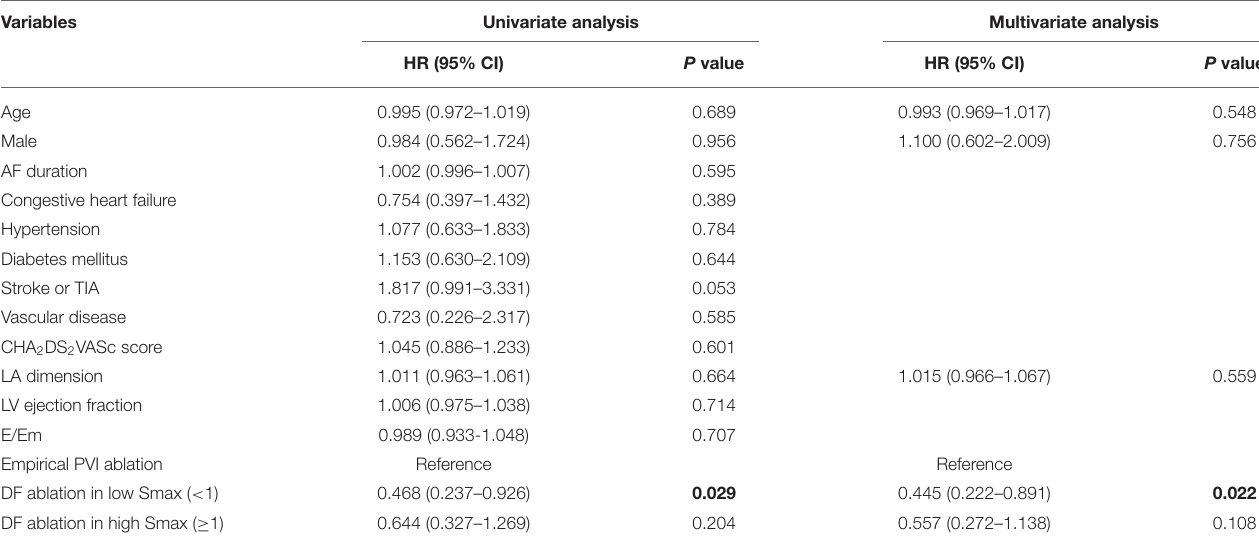
TABLE 4 | The Cox regression analysis for AF/AT recurrence in the clinical patients.